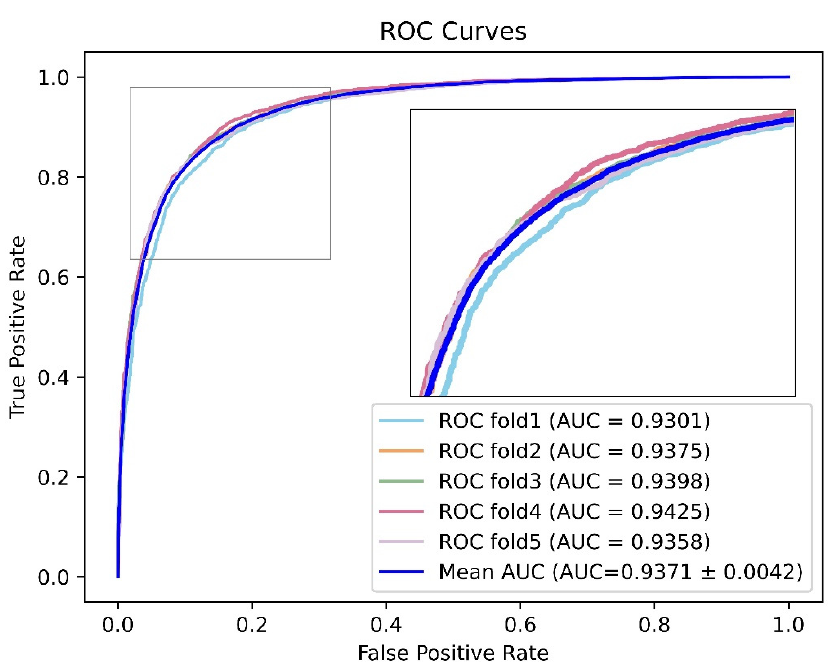
Figure 7. The model with project dimension E = 64 and encoder layers L = 6 had better performance. Table 2. Lung neoplasm associated miRNA Top 50 predicted by hmdd v3.2.